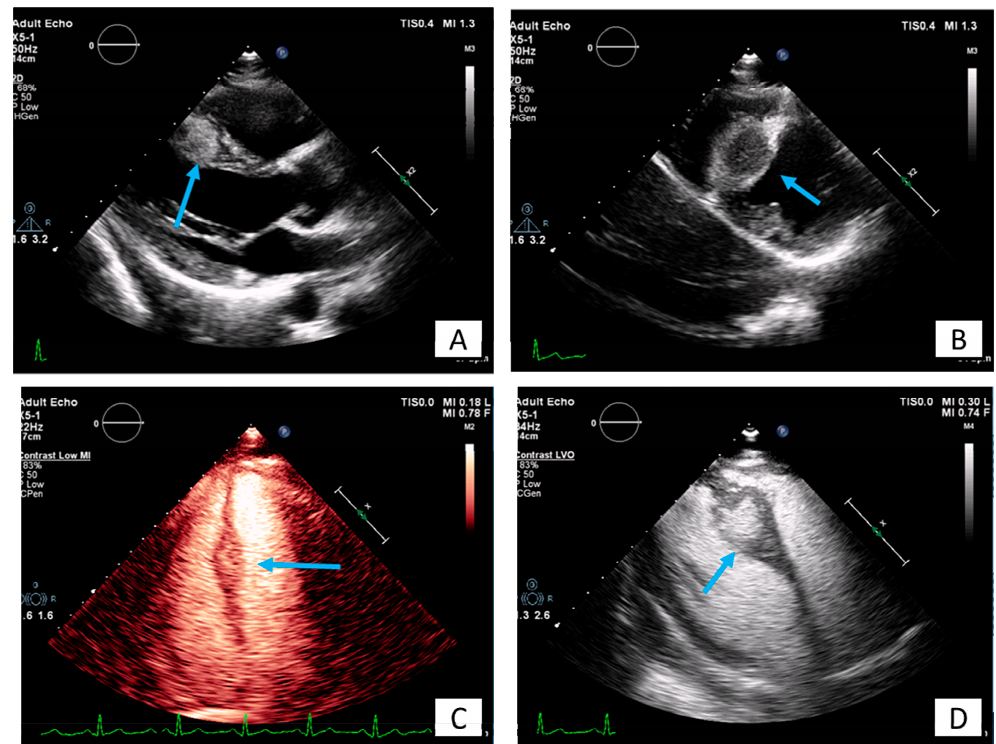
Figure 7. A 35-year-old patient with a round lesion located at the middle of intraventricular septum, known from 5 years ago, stable in size during follow-up ( A , B ). Using contrast agents, the mass is highly echogenic indicating increased vasculature with a surrounding halo ( C , D ). It is most likely an intramural